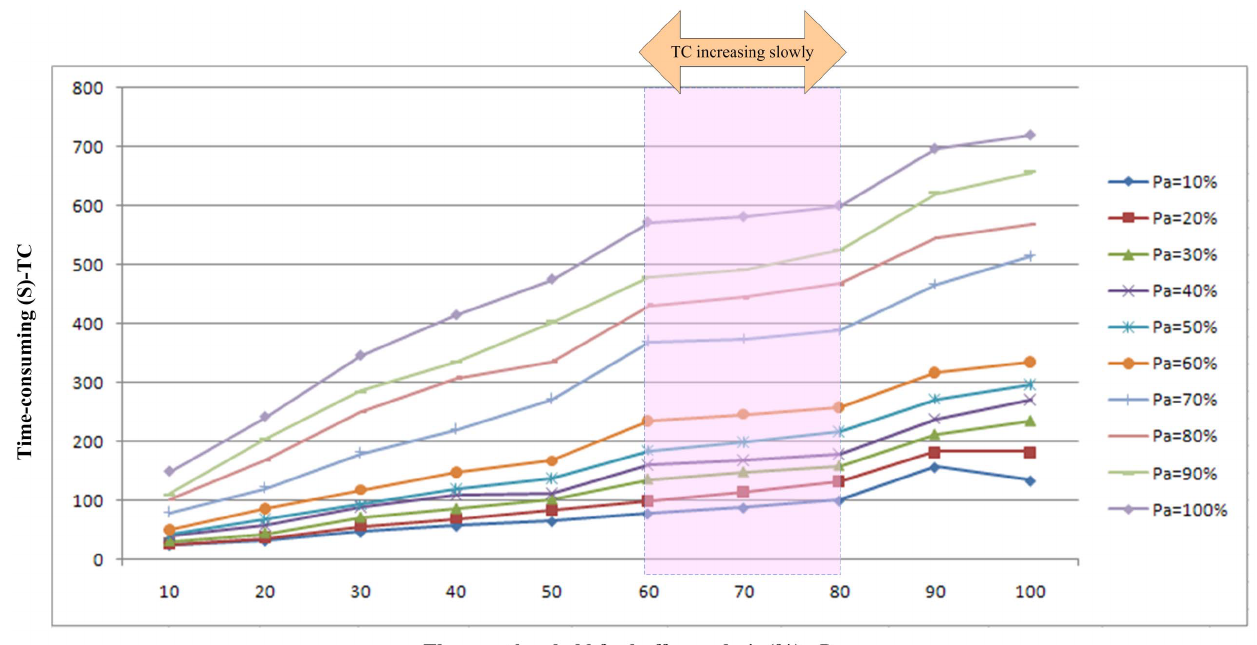
Figure 5. Relationship among P a , P buffer and TC (Time-Consuming, unit: second). doi:10.1371/journal.pone.0075852.g005 PLOS ONE |